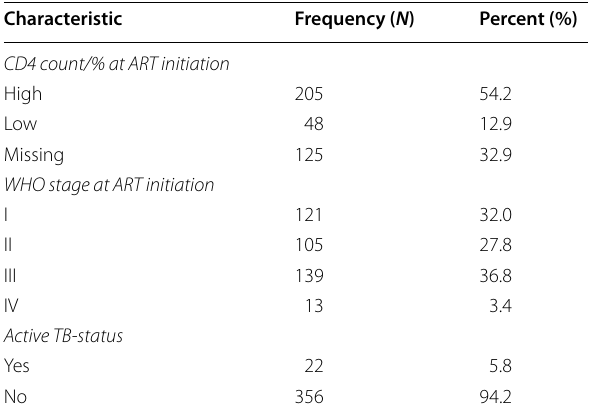
Table 2 Immunological and Clinical characteristics of HIV- positive children and adolescents on ART in Tabora region,